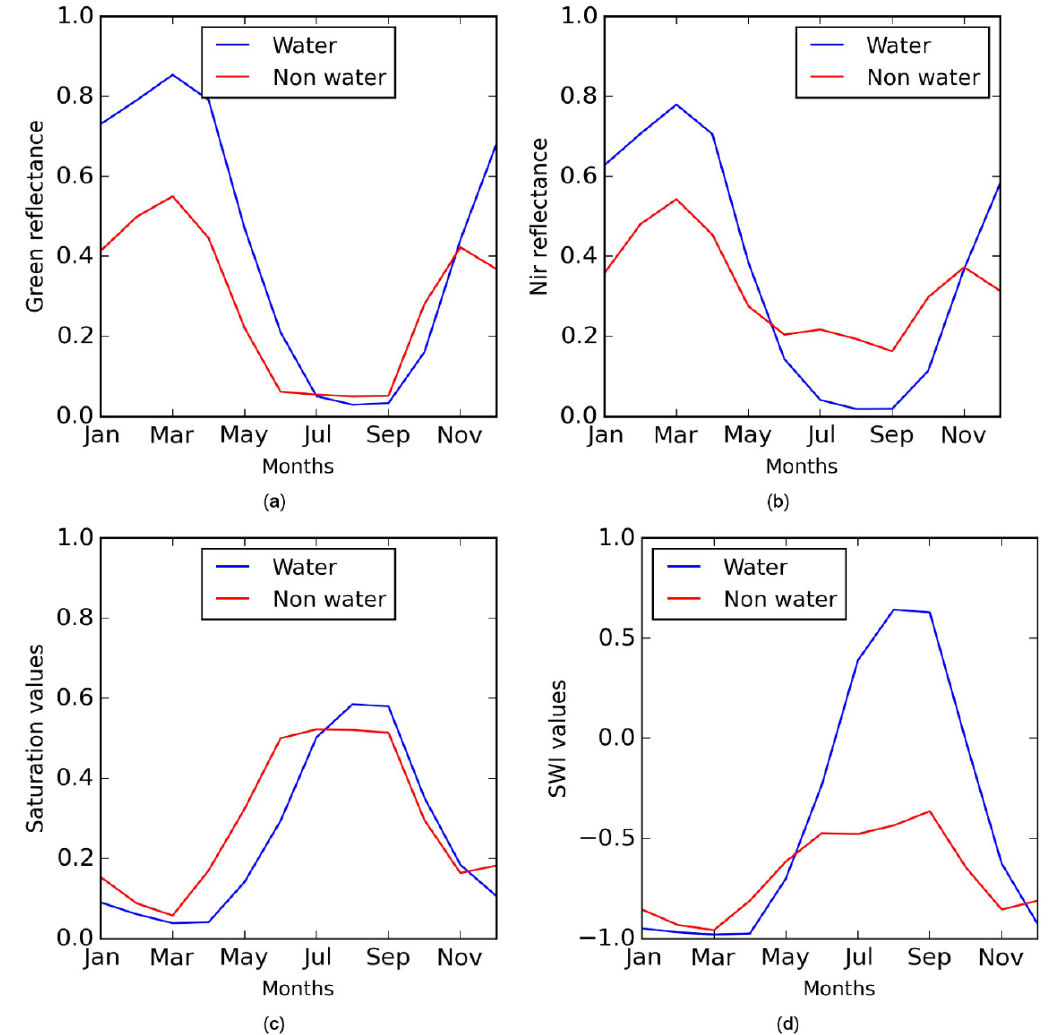
Figure 5. Monthly variation of different parameters over the water and non-water areas in a snowy region: ( a ) Green reflectance, ( b ) Near infrared reflectance, ( c ) Saturation values, ( d ) Superfine Water Index (SWI)